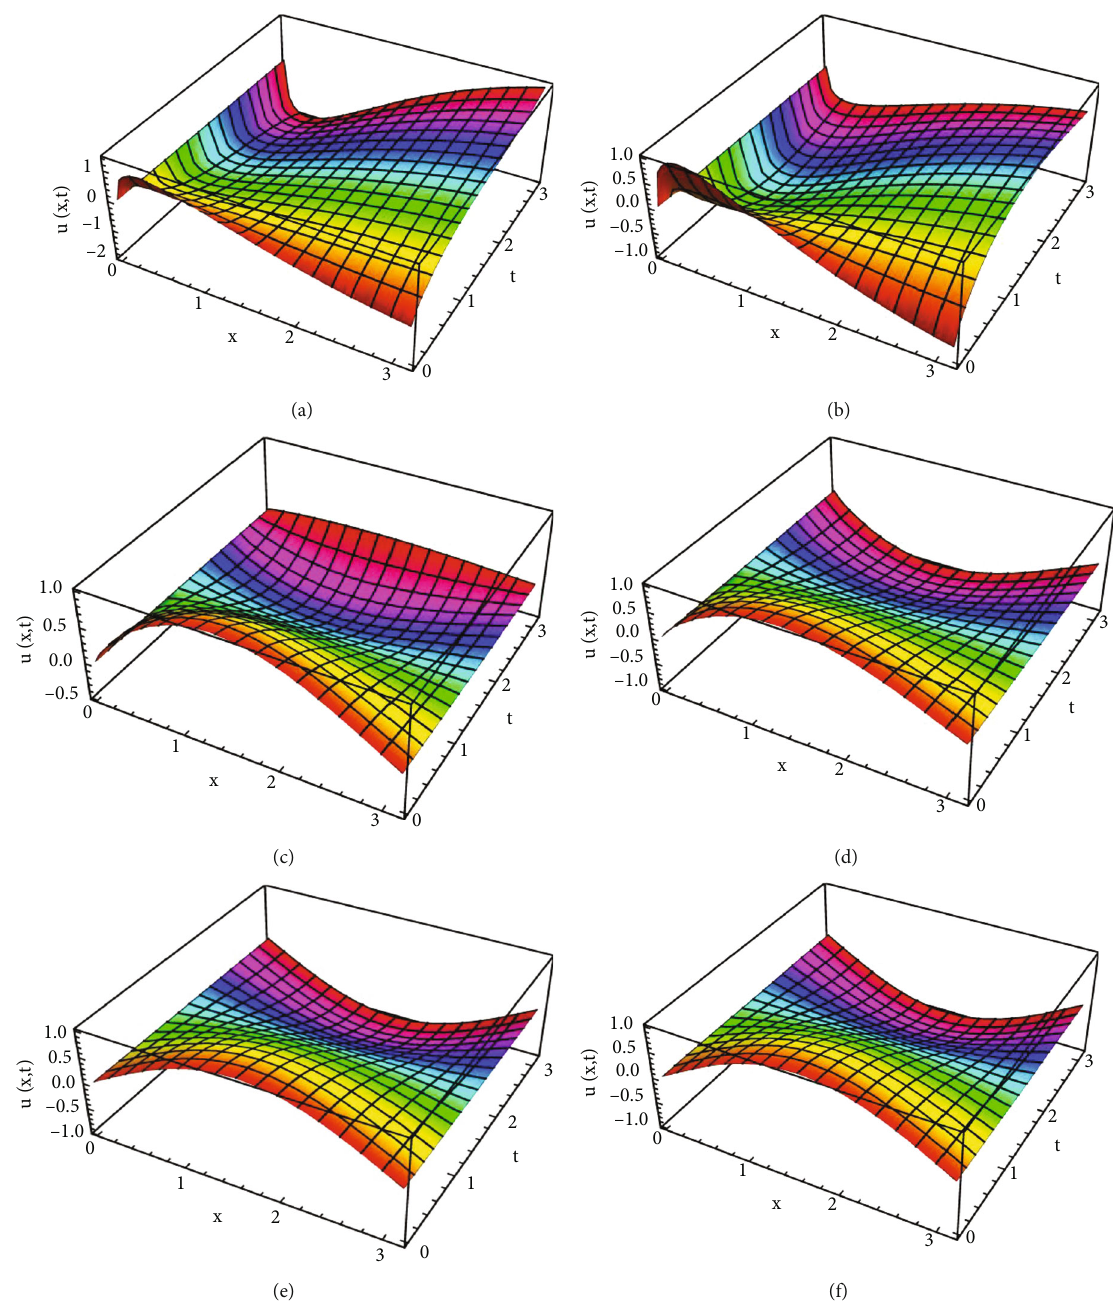
Figure 4: 3D solution plots of Example 4 obtained by the present method (a, c, e) in comparison with the exact solutions (b, d, f) at α = β = 0 : 4 , 0.8, and